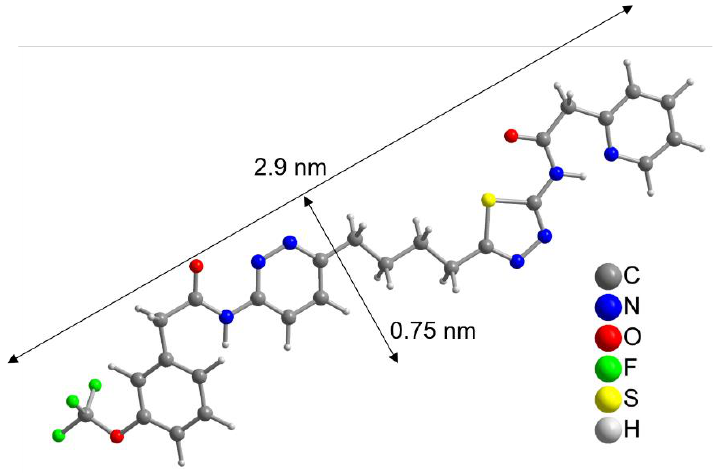
Figure 3. Linearized structure of the CB839 molecule. For the folded conformations in the glutaminase C complex, see Figure S5, SM.